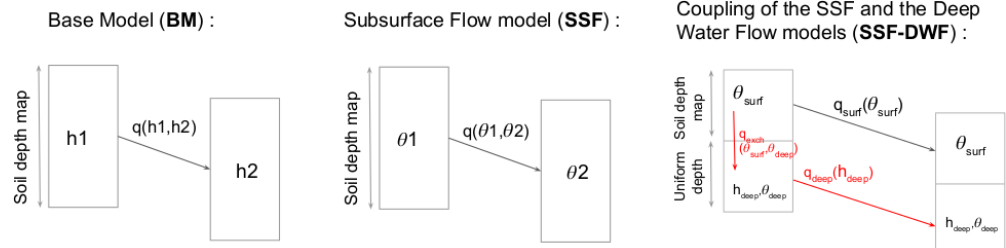
Figure 1. Summary of the main state variables and flux regarding soil processes for the three studied versions of MARINE: the base model (BM), the subsurface flow model (SSF), and the coupling of the SSF and deep water flow models (SSF–DWF). The two fluxes introduced in the SSF–DWF are colored in red. Each column represents the soil column for one grid cell of the model. h stands for water height in the soil layer and θ stands for the SSD of the layer. For the SSF–DWF model, the surf and deep subscripts are used to describe the upper soil layer and the deep soil layer,